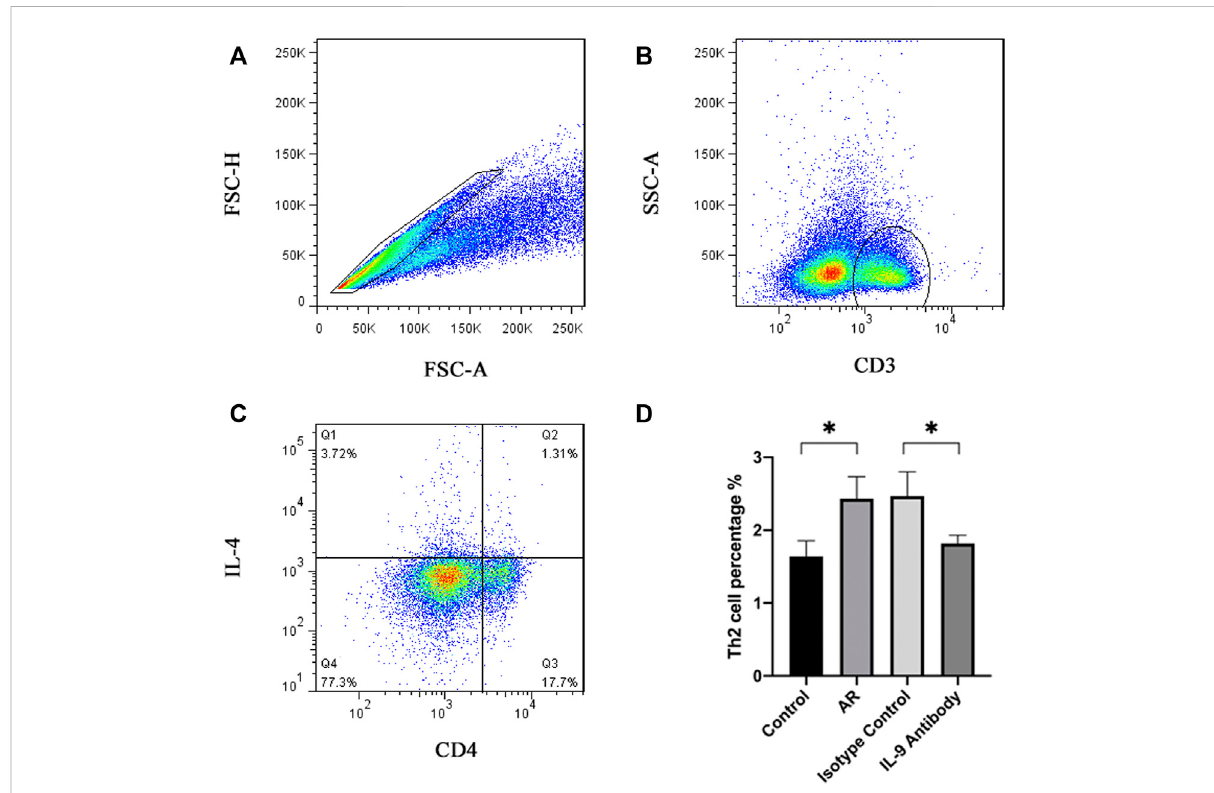
FIGURE 3 Schematicdiagramand statistical diagram of fl ow cytometry. Figure (A) – (C) shows theTh2delineationstrategy ofthecontrol group, and other groups follow this scheme. Figure (D) shows the average number of Th2 cells in each group ( n = 5). One way ANOVA/Tukey was used for statistical analysis. All results were mean ± SEM. * p <